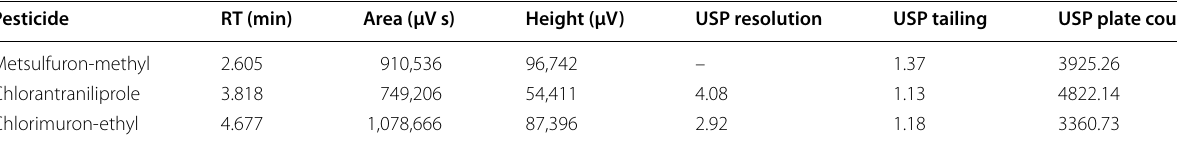
Table 4 System suitability parameters of the developed RP-HPLC